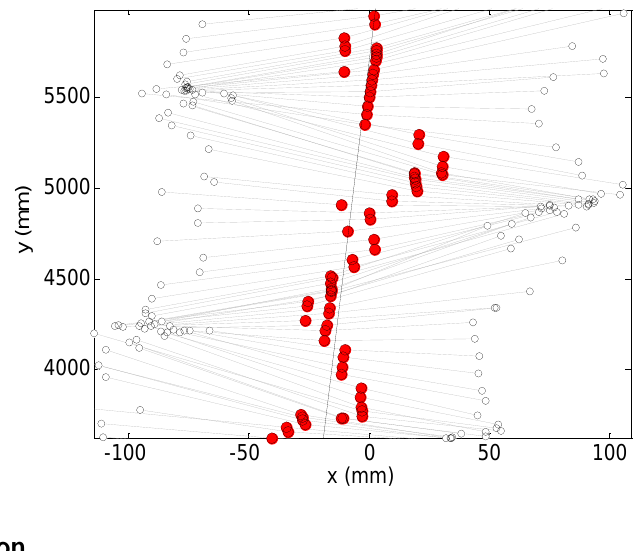
Figure 7. Graphic example of the procedure used to estimate the straight